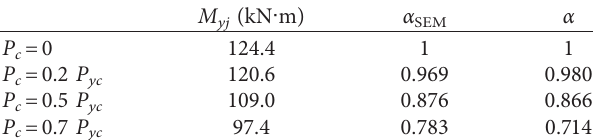
Table 3: Reduction factor of the yield